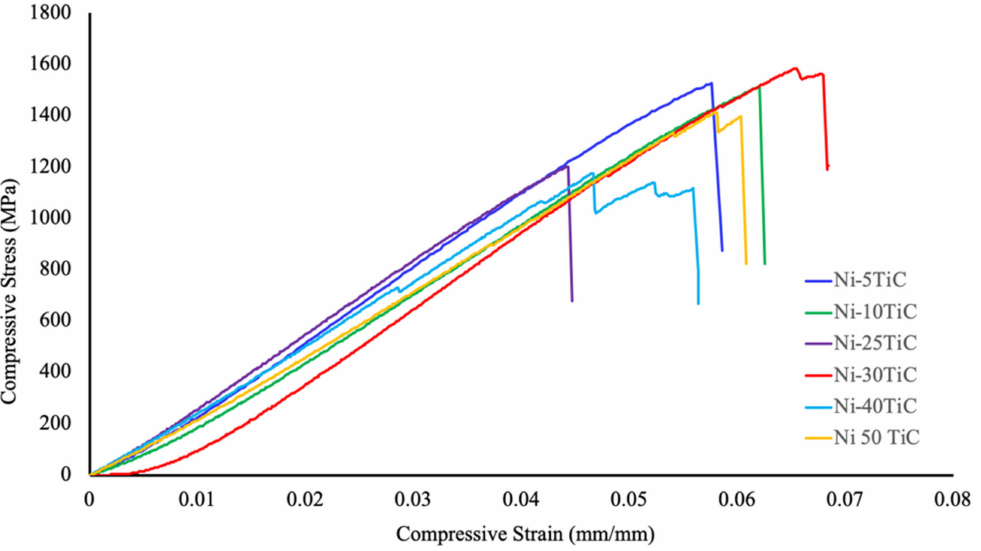
Figure 6. Compressive stress versus strain plots of Ni-TiC composites. Table 2. Mechanical properties of Ni-TiC